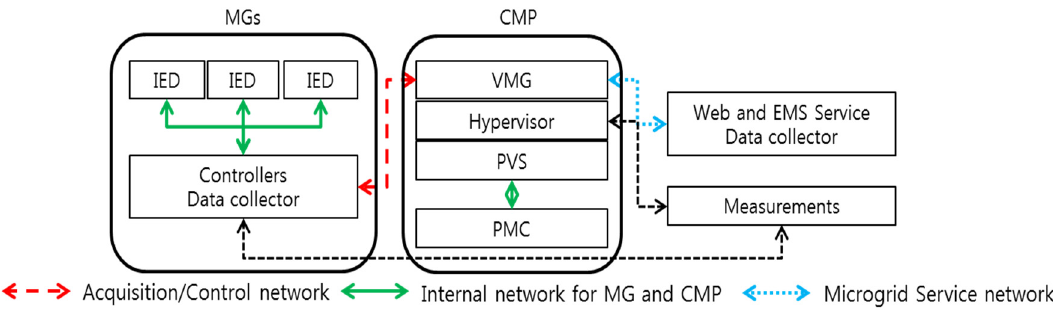
Figure 6. Measurements of the utilization of real-time cluster microgrid platform.